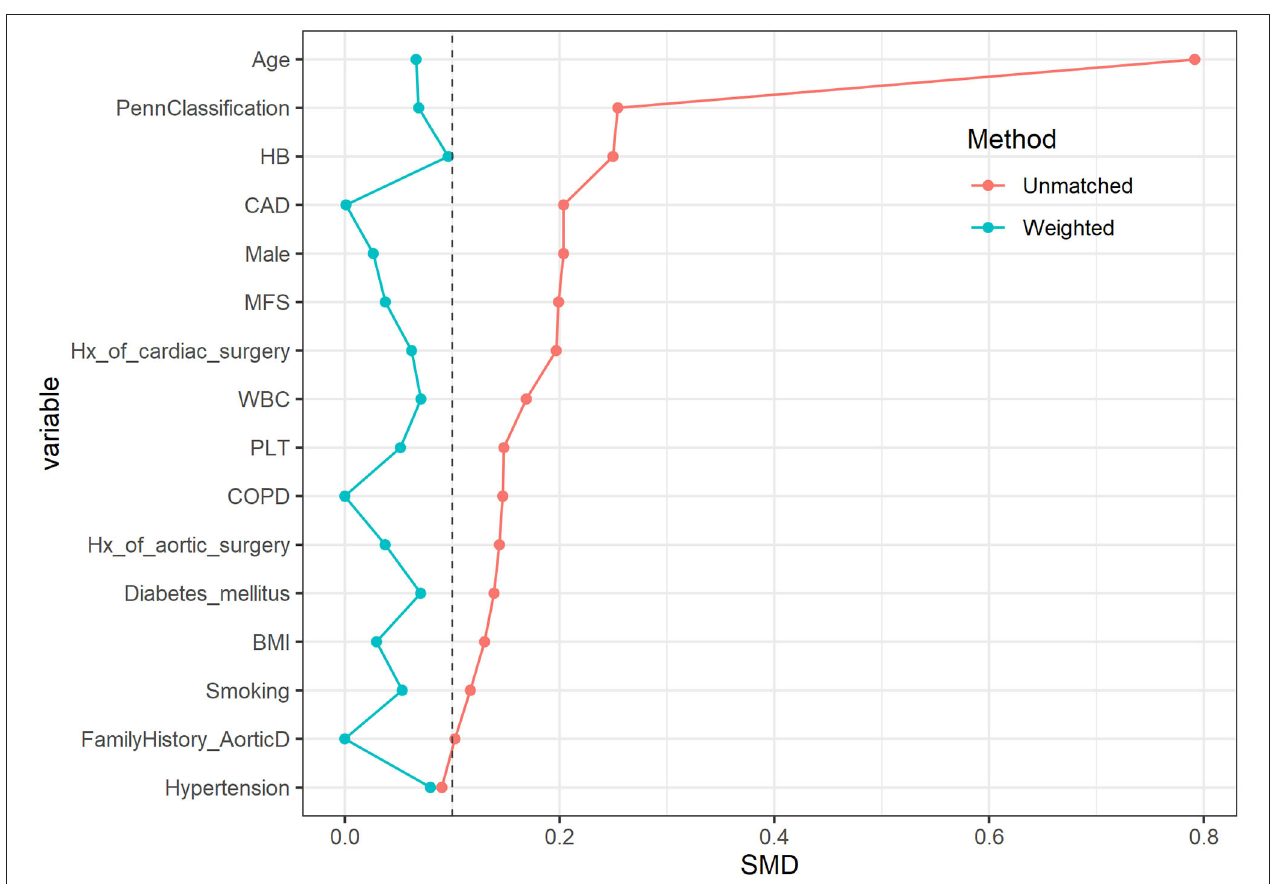
FIGURE 1 | The love plot of standardized differences before and after matching. After using the matching weight method, the 3 groups were well-matched at baseline with the SMD of each variable <